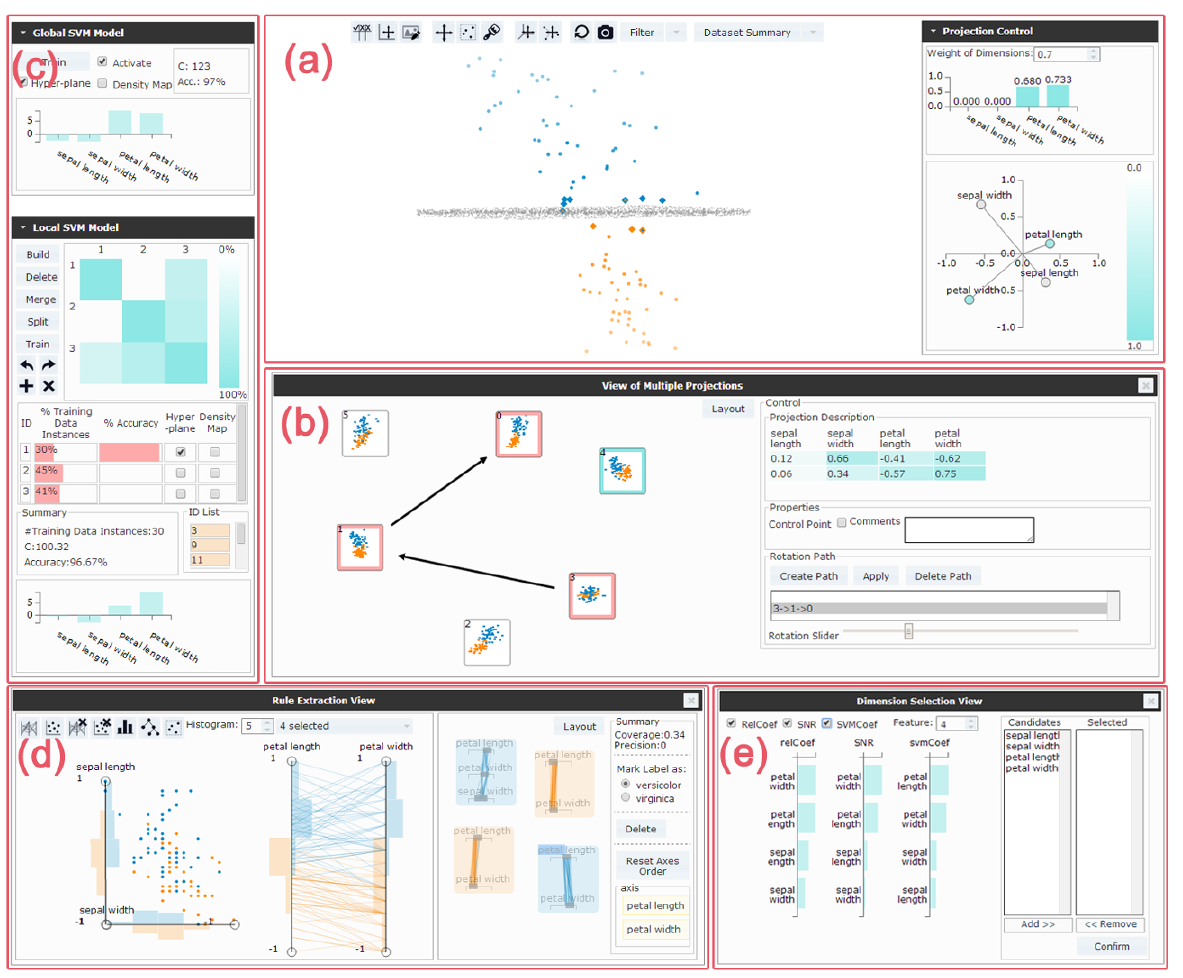
Fig. 3 Interface of EasySVM: (a) the data view, (b) the view of multiple projections, (c) the SVM model building view, (d) the rule extraction view, and (e) the dimension selection